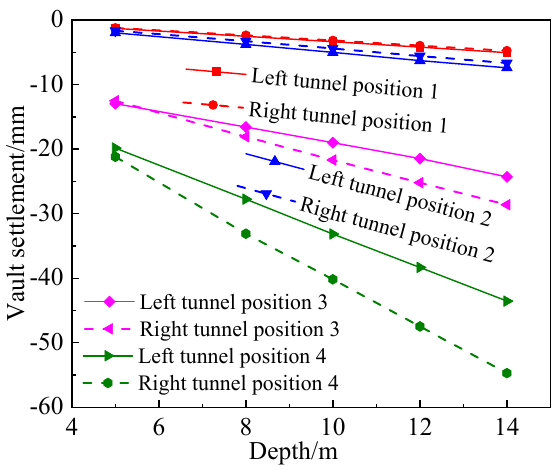
Figure 16. Vault settlement at different soil-rock interface positions varies with burial depth.